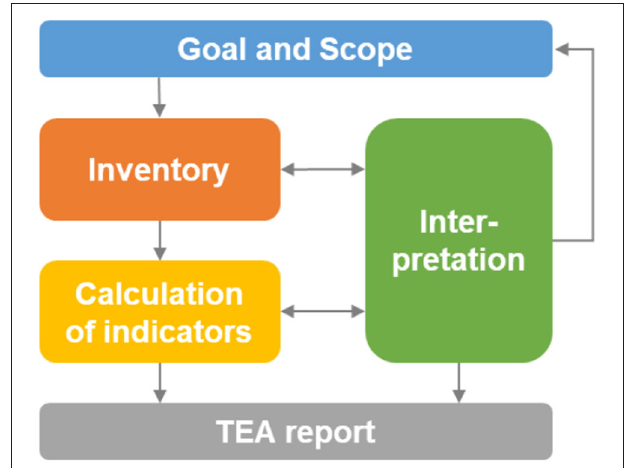
FIGURE 2 | Phases of techno-economic